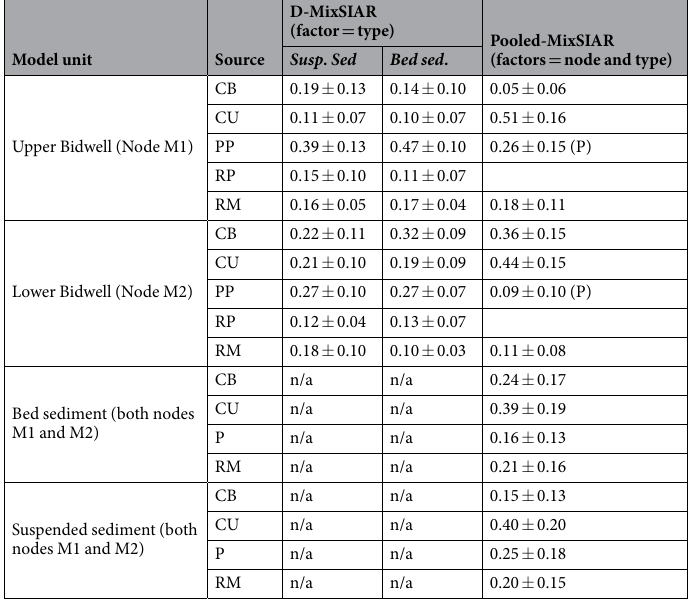
Table 2. D-MixSIAR and pooled MixSIAR source apportionment data for the Bidwell watershed for (a) model runs with uninformative prior where CB is channel bank, CU is cultivated soil, PP is permanent pasture (node M1 only), RM is rotational pasture (i.e. cultivated at some point in the past), P is the former 2 combined (for pooled MixSIAR), and RM is material sampled from the roads. Note pooled MixSIAR delivers posterior distributions according to either node or type as factors.